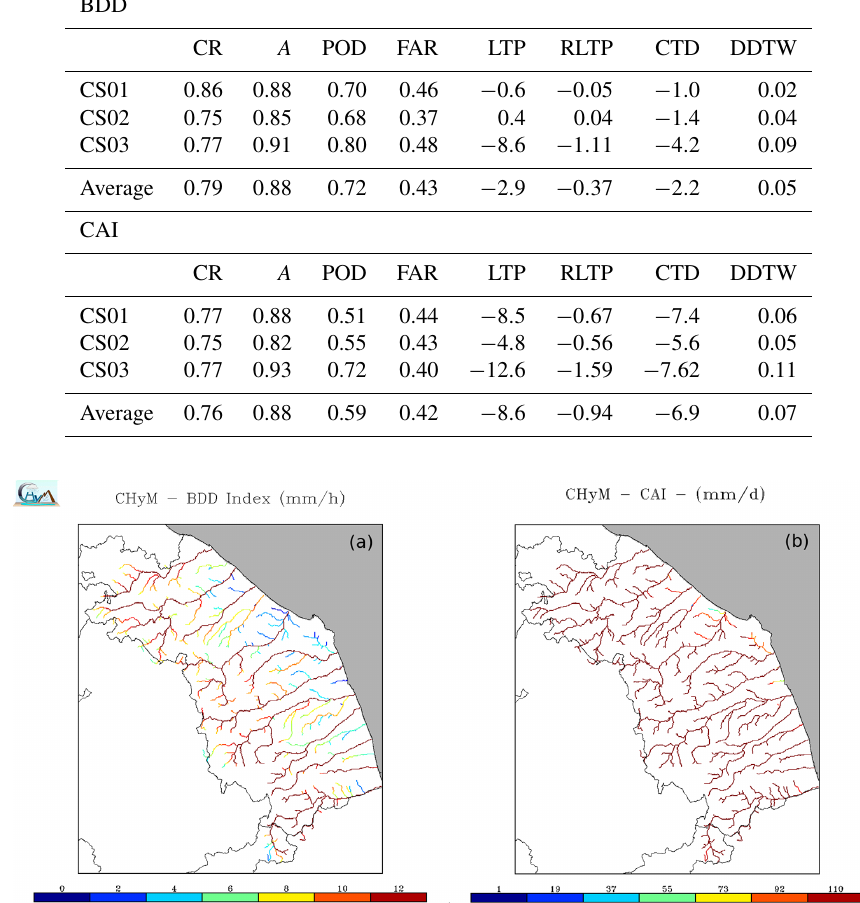
Figure 10. CS02 24h maps of the BDD index (a) and the CAI (b) obtained for 11 November 2013, by forcing CHyM with observed rainfall data. Warmer colours indicate river segments with higher flood stress. In both figures, the Marche region drainage network is highlighted.